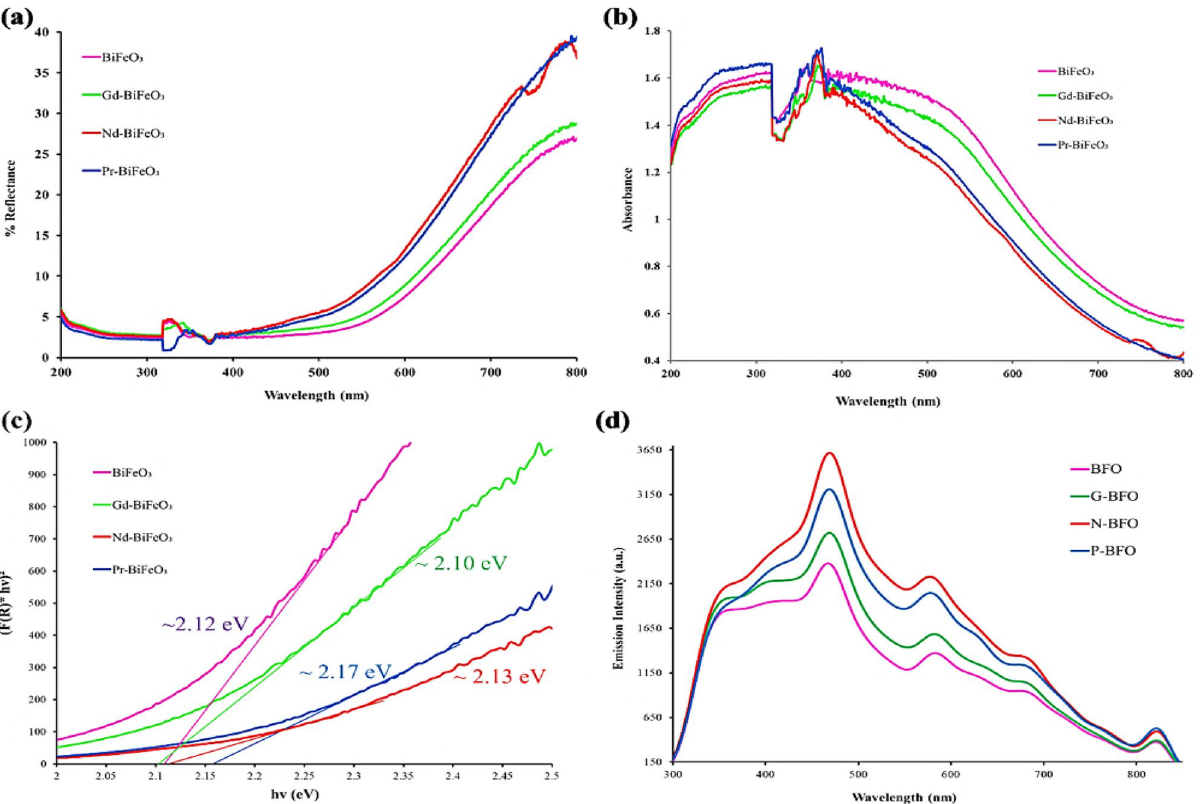
Figure 6. ( a ) UV–Vis diffuse reflectance spectra of synthesized bare/doped BiFeO 3 , ( b ) UV–Vis diffuse absorbance spectra of synthesized bare/doped BiFeO 3 , ( c ) Tauc plots against[F(R)*hv] 2 versus hv (eV), and ( d ) Photoluminescence spectra of synthesized bare/doped BiFeO 3